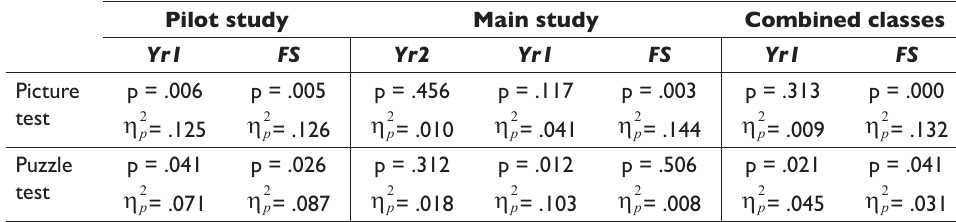
Table 2: Assessments in spatial–temporal tests in which the change in scores over time for the intervention groups was greater than for the controls Pilot study Main study